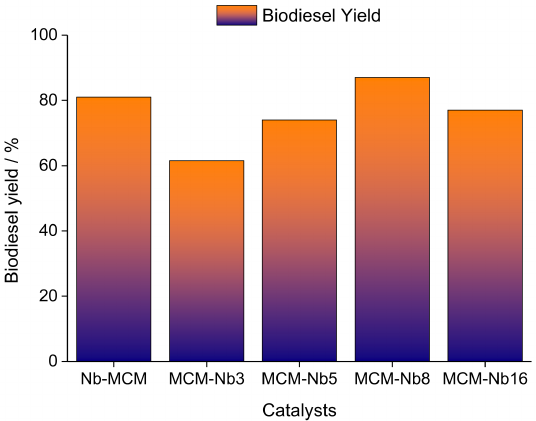
Figure 23. Effects of Niobium load on the Biodiesel production from sunflower oil over the different Niobium/MCM catalysts. In the MCM-Nb3, MCM-Nb-5, MCM-Nb8, and MCM-Nb16, the number represents the wt% of Nb 2 O 5 incorporated (3, 5, 8, and 16 wt%) to the MCM-41. Reaction conditions: methyl alcohol: sunflower oil molar ratio (12:1), catalyst (5 wt% in relation to the oil), temperature (200 ◦ C), time (4 h) (adapted from